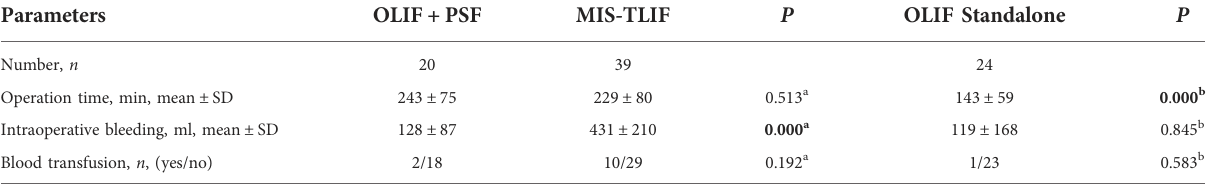
TABLE 3 The general comparison of OLIF+PSF, OLIF standalone and MIS-TLIF.